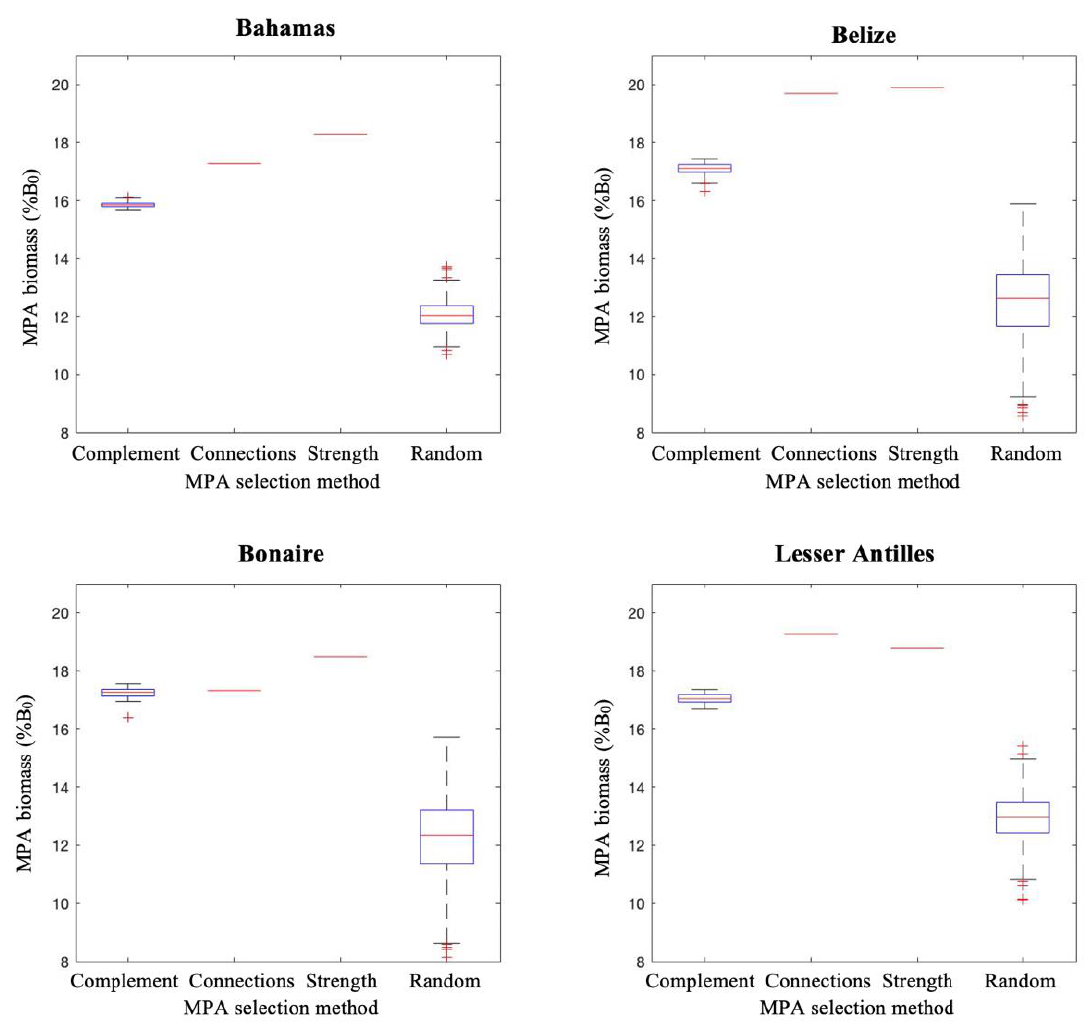
Figure 6. Population model results for fish biomass in protected areas at year 100 of simulations for different MPA selection strategies, at 20% MPA coverage. Simulated MPA biomass is represented as a percentage of B 0 , the hypothetical network biomass in conditions where no fishing occurs. Scenarios are described in the text.